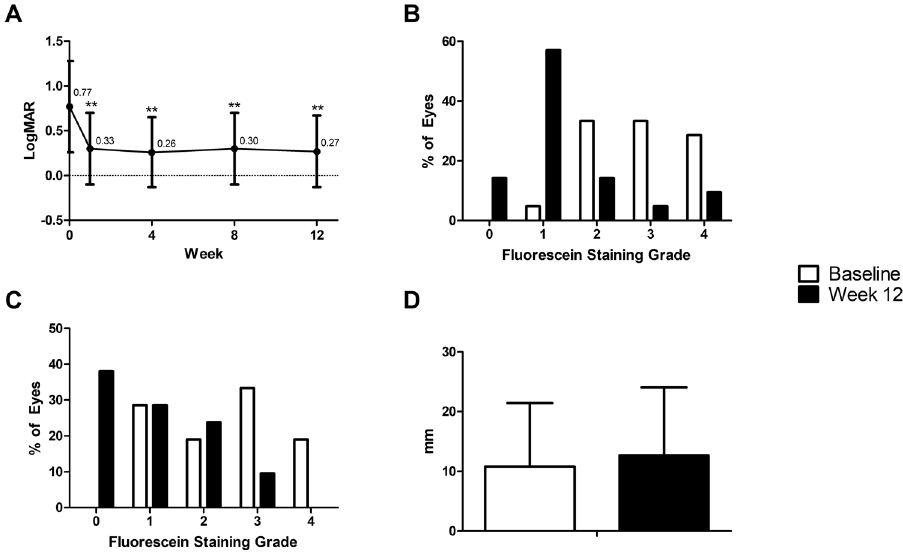
Figure 1. Objective efficacy outcomes of the LK scleral lens clinical trial. Significant improvement in BCVA was seen after 1 week of the LK scleral lens wearing and was stable throughout the 12-week study period. Baseline BCVA was 0.77 ± 0.51 logMAR (range 0.30–2.00) and improved to 0.30 ± 0.40 logMAR (range − 0.18–1.00), 0.26 ± 0.39 logMAR (range − 0.18–1.00), 0.30 ± 0.40 logMAR (range − 0.08–1.00) and 0.27 ± 0.40 logMAR (range − 0.08–1.00) at 1, 4, 8 and 12 weeks, respectively (compared to baseline; P < 0.001 at all weeks, paired t-test) ( A ). Baseline corneal fluorescein staining grade 3 or 4 was seen in 61.90% (13 eyes). After 12 weeks of LK scleral lens wearing, the proportion of corneal fluorescein staining grade 3 or 4 had decreased to 14.29% (3 eyes). A majority of subjects (71.43%, 15 eyes) were either grade 1 or 0 at week 12 (Grade 0–2 vs 3–4, from baseline to week 12; P = 0.0036, Fisher’s exact test) ( B ). Conjunctival fluorescein staining grade 3 or 4 were observed in 52.38% (11 eyes) and grades 1 or 0 in 28.57% (6 eyes) at baseline. At week 12, the proportion of grade 3 or 4 had decreased to 9.52% (2 eyes), while the proportion of grade 0 or 1 had increased to 66.67% (14 eyes) (Grade 0–2 vs 3–4, from baseline to week 12; P = 0.0063, Fisher’s exact test) ( C ). The Schirmer test revealed aqueous tear production of 10.81 ± 10.60 mm and 12.67 ± 11.40 mm at baseline and week 12, respectively ( P > 0.05, paired t-test) ( D ). BCVA: Best-corrected visual acuity, logMAR: log of minimal angle of resolution. ** P < 0.001, paired t-test.